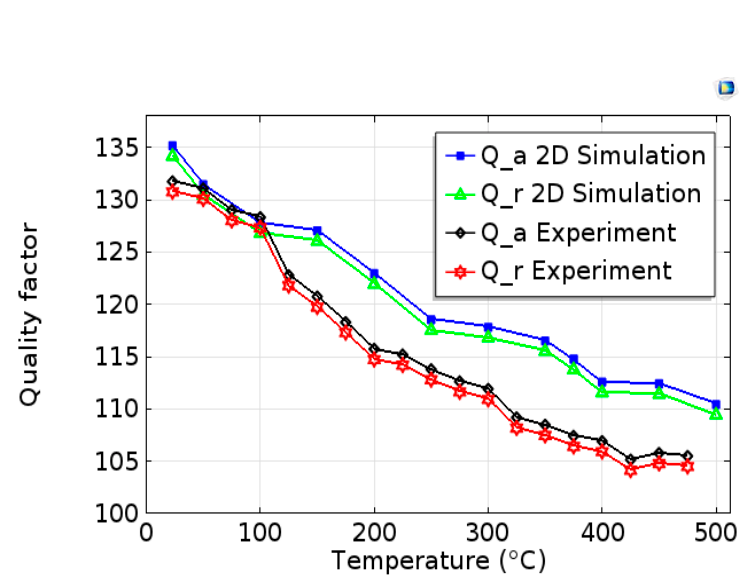
Figure 8. Evolution of the quality factor Q as a function of temperature for experimental and simulated devices, for resonance and anti-resonance frequencies.